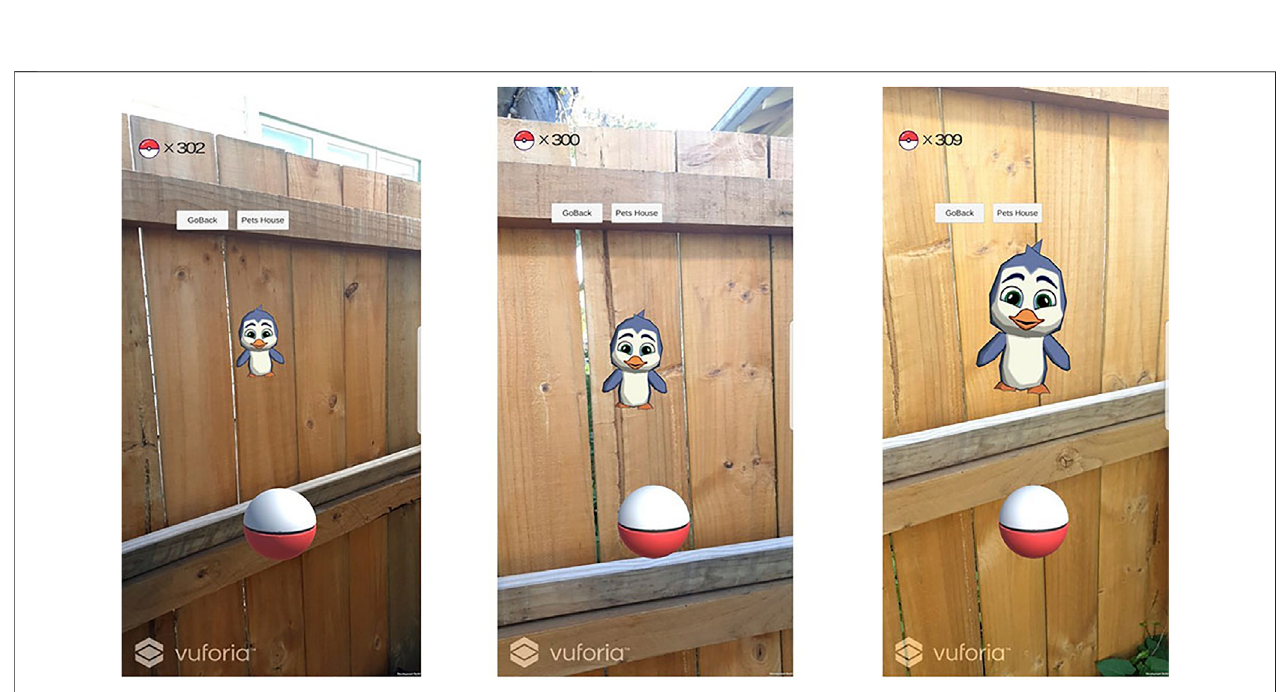
FIGURE 6 | The three sizes of Pokémon-like